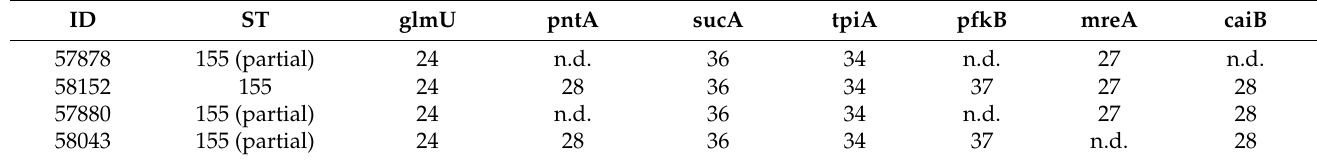
Table 3. Results of multi-locus sequence typing (MLST)